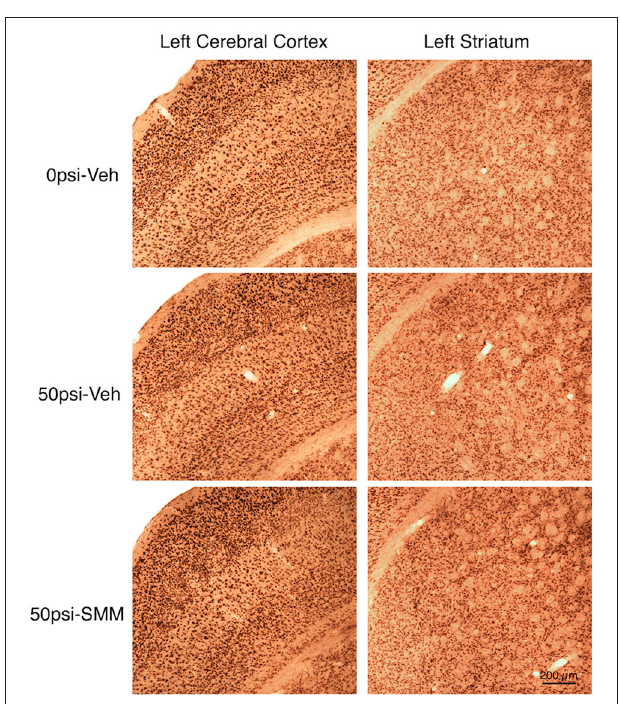
FIGURE 3 | Images showing the effect of TBI and SMM-189 on NeuN + neurons in left cerebral cortex and striatum at 2–3 months post-blast. Neither focal nor diffuse neuron loss is evident in the 50-psi vehicle-treated cortex or striatum, compared to 0-psi vehicle-treated cortex and striatum. Similarly, the abundance of cortical and striatal neurons does not appear obviously different in the 50-psi SMM-189 treated mice from that in either of the other two groups. Magnification is the same for all panels. Stereology, nonetheless, revealed neuron loss in both in 50-psi vehicle-treated mice.